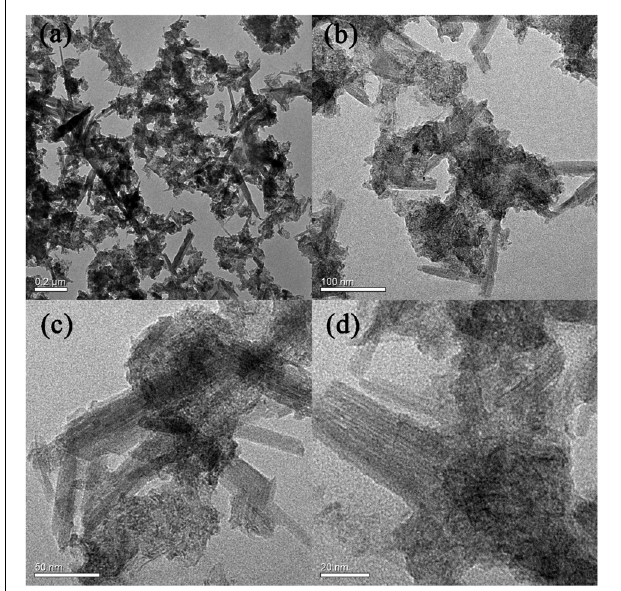
FIGURE 3 | TEM images of BC/MnO 2 under different magnification: (a) 0.2 µ m, (b) 100 nm, (c) 50 nm, and (d) 20 nm.